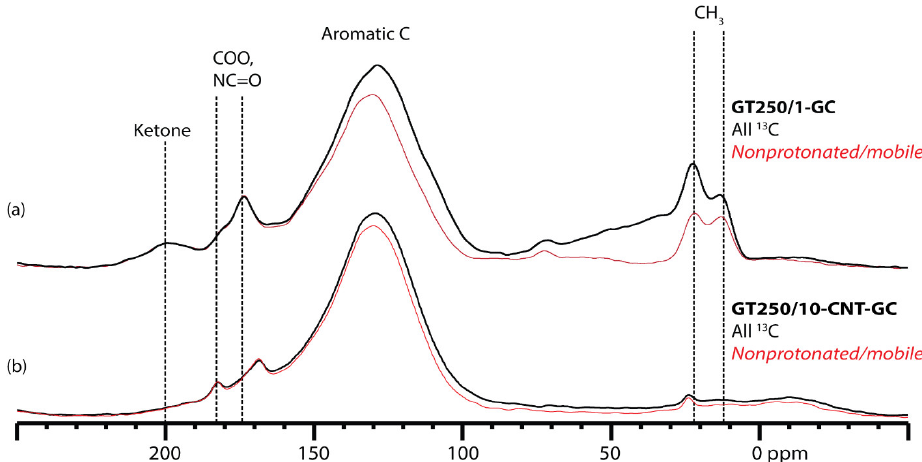
Figure 4. 13 C NMR spectra of 13 C-glucose-labeled glucose–taurine materials. Synthesis details in Table